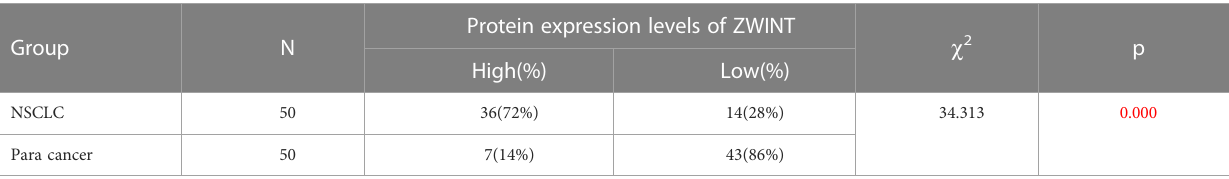
TABLE 4 Correlation between ZWINT and E-cadherin, Vimentin, and Slug protein expression (n). E-cadherin Vimentin Slug ZWINT High Low High Low High Low High 13 22 23 13 26 10 Low 11 4 4 10 9 r -0.332 0.318 0.338 P 0.020 0.026 0.018 Red values means that the p-value is less than 0.05, indicating statistical signi fi